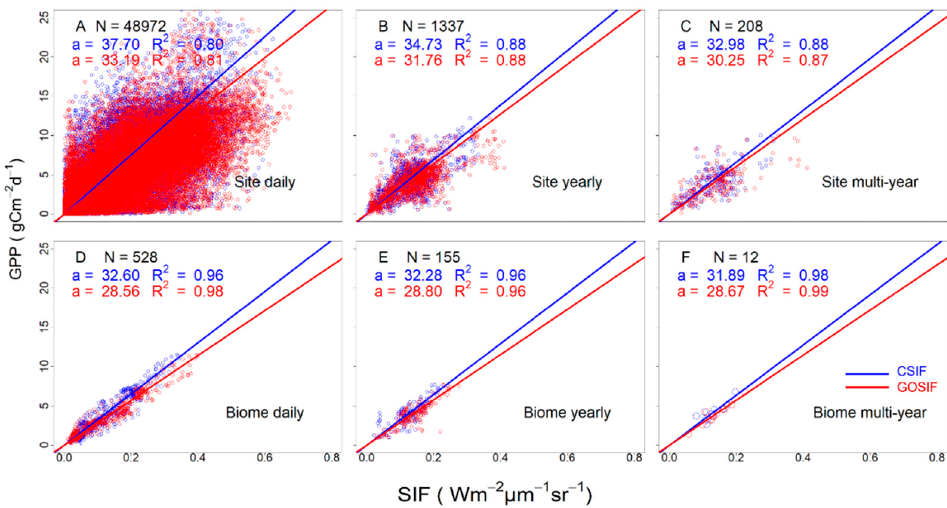
Figure 8. Scatter plots and linear regression of SIFc (both CSIF and GOSIF) and GPP for all biomes across six spatiotemporal scales ( p < 0.001). The statistical measures for the linear regression listed in the top left corner correspond to different colors. All the linear regressions were forced to go through the origin. The solid lines represent the fitted major axis regression models for different